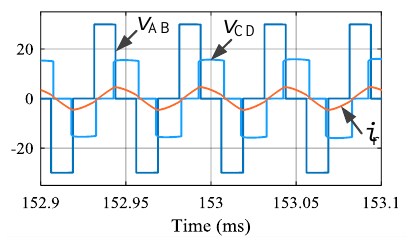
Figure 15. v AB , v CD and the transformer primary side current i r ( φ 1 = π /2, θ = π /2).